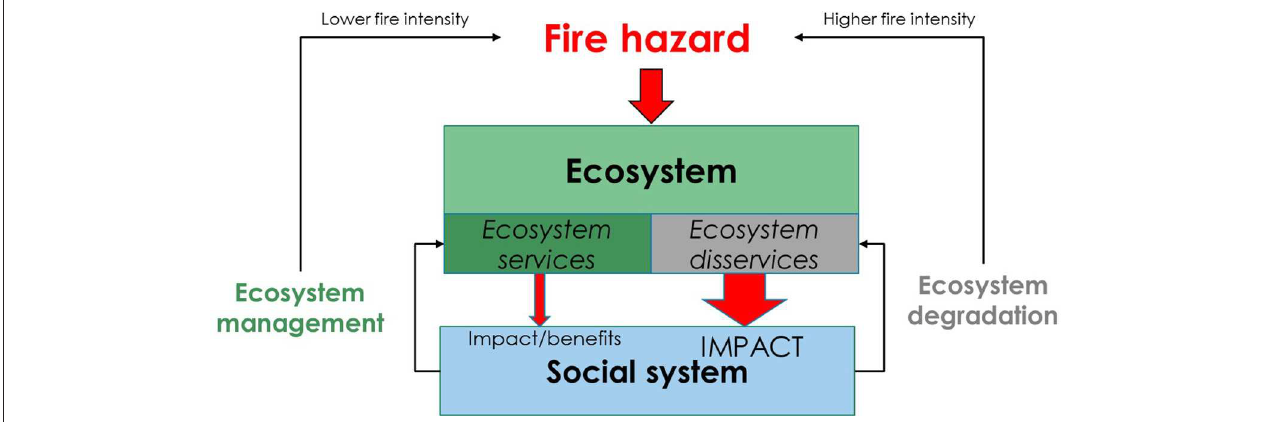
FIGURE 1 | Conceptual framework summarizing interactions between the hazard and the social-ecological system. Although social and ecological systems are integrated with one another, here are maintained separately for graphical